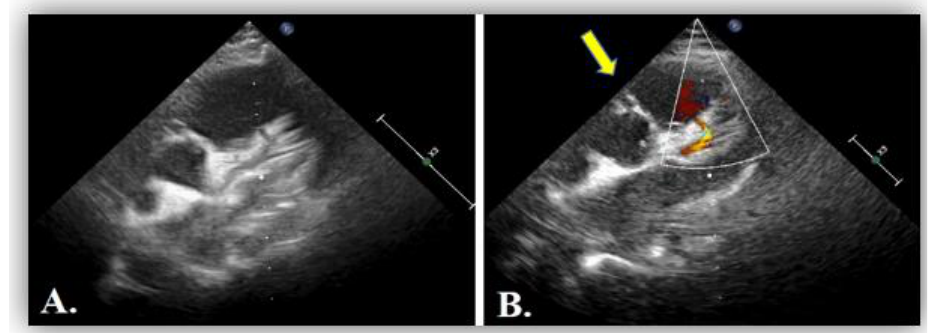
Figure 7. ( A ) Transthoracic echocardiography in parasternal short axis view showing dilated left coronary artery, LCA. ( B ) Artefactuous image of the right coronary artery showing the apparently normal origin of the right coronary artery from the aorta at the 11 o’clock position (yellow arrow).